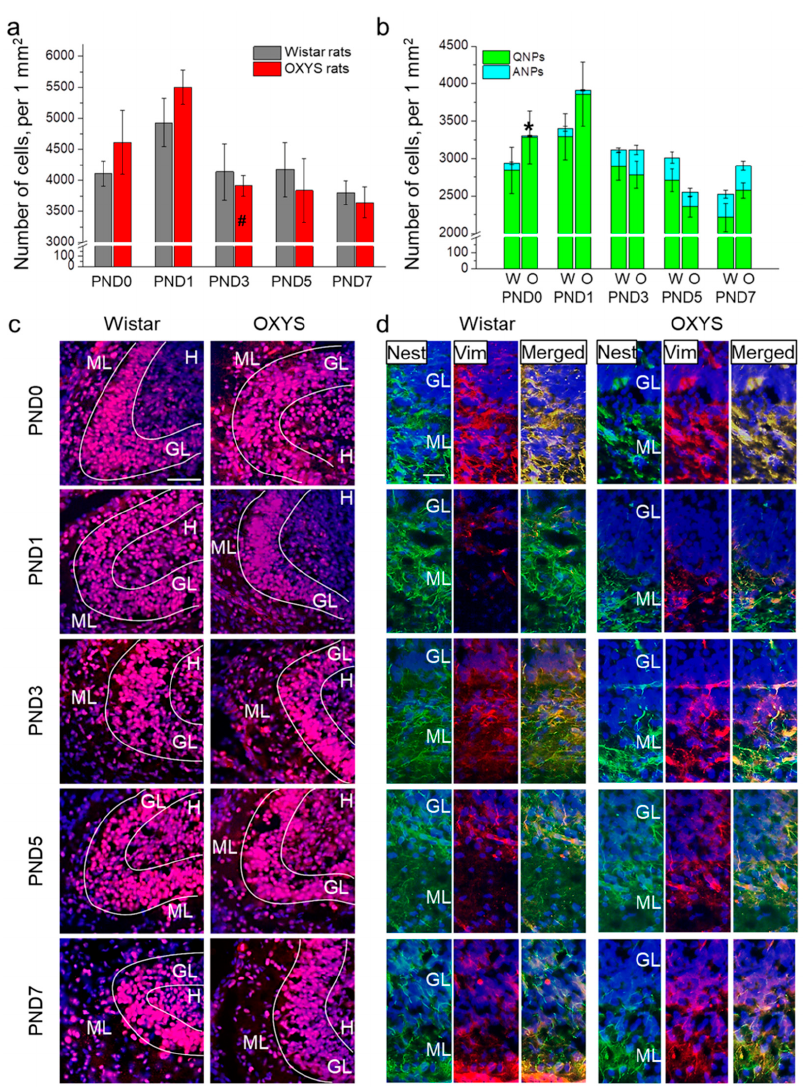
Figure 1. The density of proliferating cells and neuronal progenitors in the DG of OXYS and Wistar rats during the first postnatal week. ( a ) We did not observe any inter-strain differences in the density of proliferating cells in the DG; the only age-related difference was the decrease in proliferating cell density in OXYS rats from PND1 to PND3. ( b ) OXYS rats were born with a lower density of ANPs in the DG; nevertheless, by PND1 this difference had disappeared. ( c ) Immuno- histochemical staining of the DG with antibodies against Ki-67 (red); the scale bar is 50 μ m. ( d ) Immunohistochemical staining of the DG with antibodies against nestin (green) and vimentin (red); the scale bar is 20 μ m. DAPI (blue) indicates cell nuclei. W: Wistar, O: OXYS, GL: granular layer of DG, ML: molecular layer of DG, H: hilus, Nest: nestin, Vim: vi- mentin. The data ( a , b ) are presented as mean ± SEM; * p < 0.05 for differences between the strains; # p < 0.05 for differences from a previous time point.